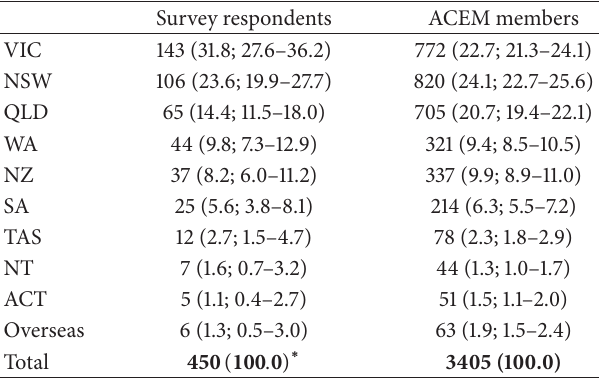
Table 1: Distribution of respondents by region [number (percent- age; 95%